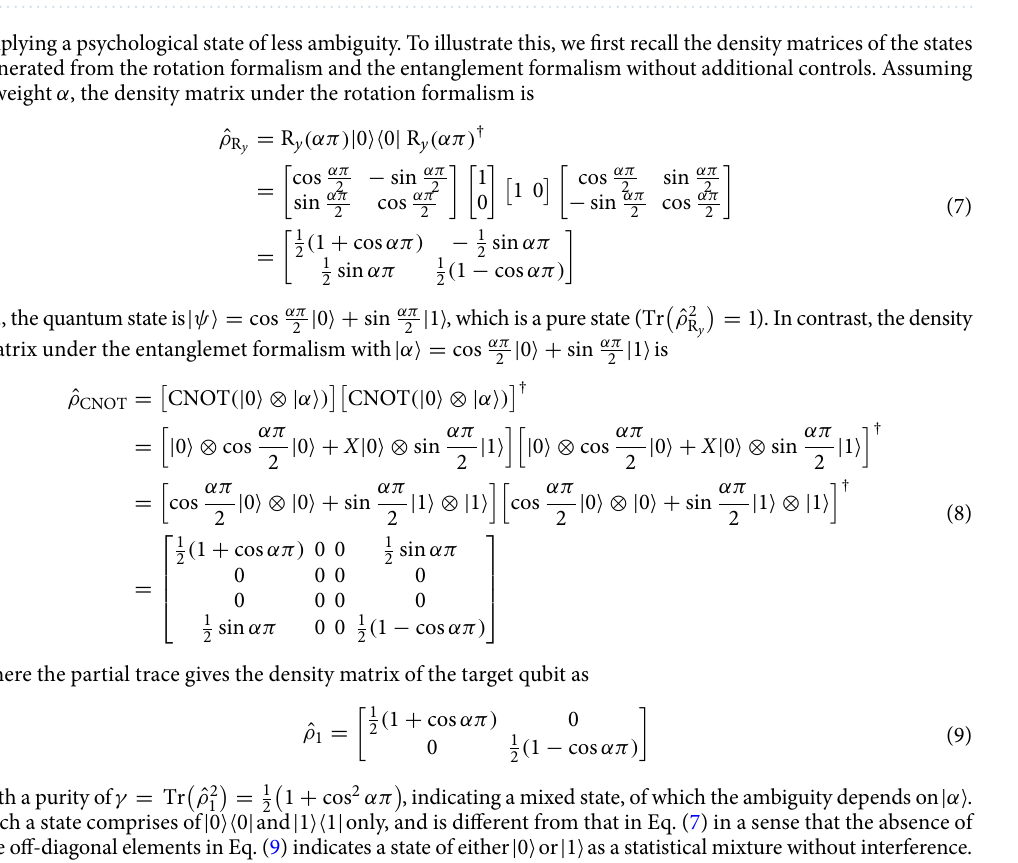
Figure 12. Comparison of vagueness in terms of fuzzy-set–based and qubit-based scales. The text color denotes the type of description for ease of comparison. The concepts associated with the blue and orange texts only appear in quantum logic, and thus are absent in the fuzzy-set–based